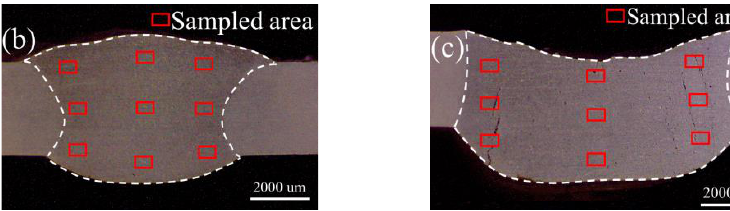
Figure 6. Sampled areas for typical weld profiles [25]. Heat input of ( a ) 122 J/mm; ( b )177 J/mm; ( c ) 231 J/mm.